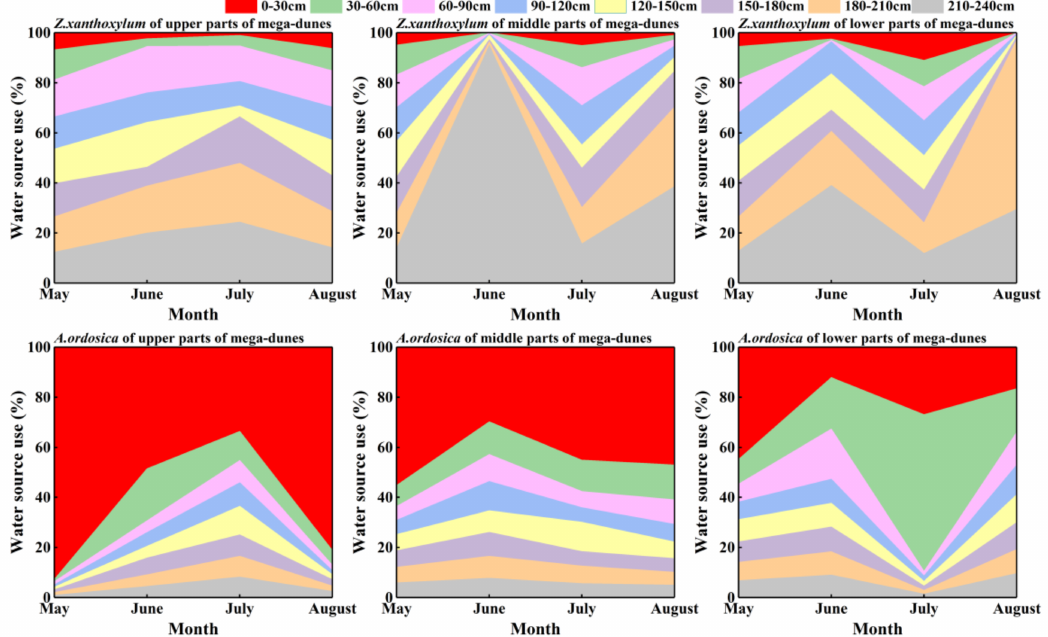
Figure 7. Seasonal variations in water uptake proportions from different soil layers for Z. xanthoxylum and A. ordosica . The data were obtained via the Iso—source